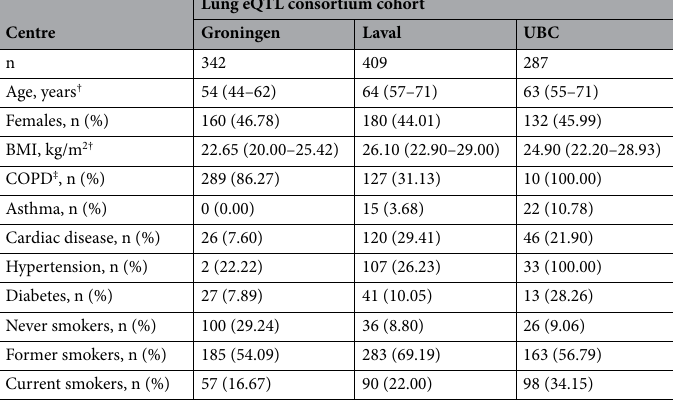
Table 1. Study cohort demographics. † Median (interquartile range). ‡ Chronic obstructive pulmonary disease. Denominators for the percentages are based on the number of non-missing